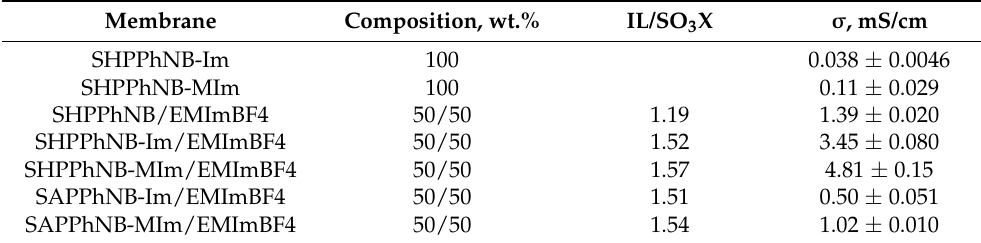
Table 3. Ionic conductivities of the membranes. Membrane Composition, wt.%